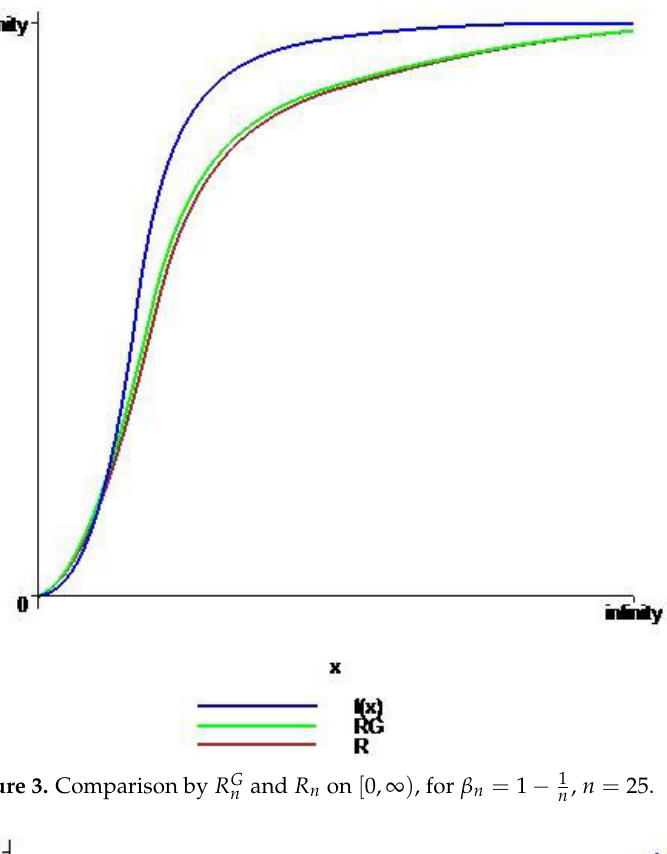
Figure 3. Comparison by R G n and R n on [ 0, ∞ ) , for β n = 1 − 1